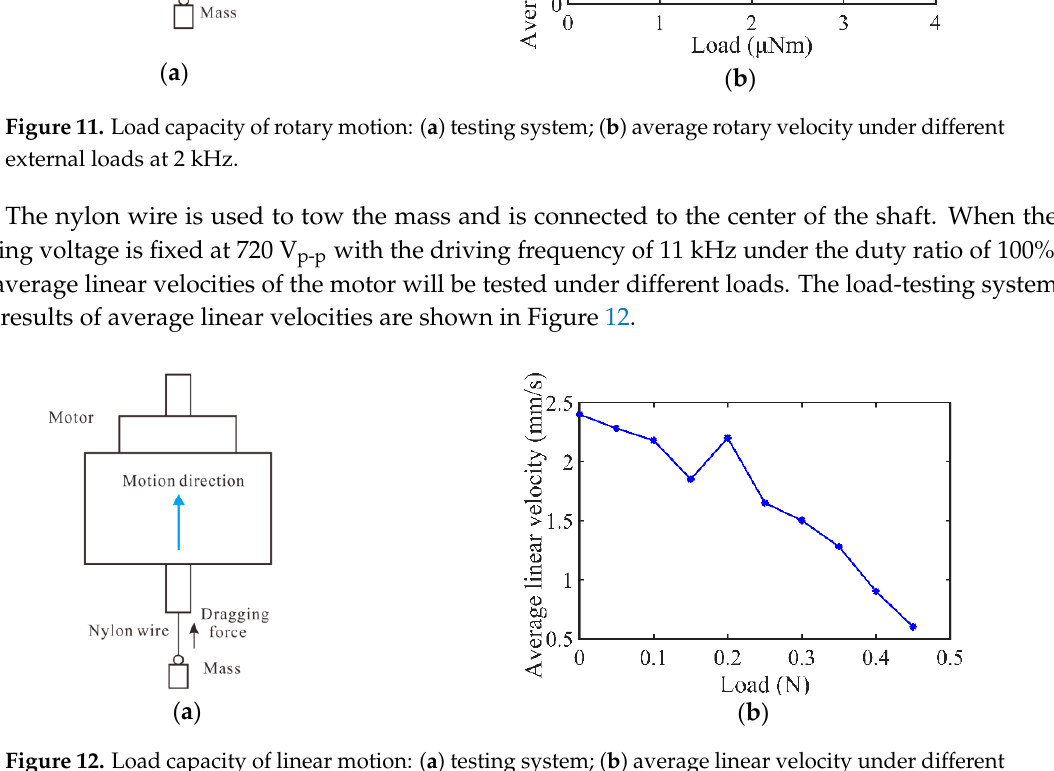
Figure 12. Load capacity of linear motion: ( a ) testing system; ( b ) average linear velocity under different external loads at 11 kHz.